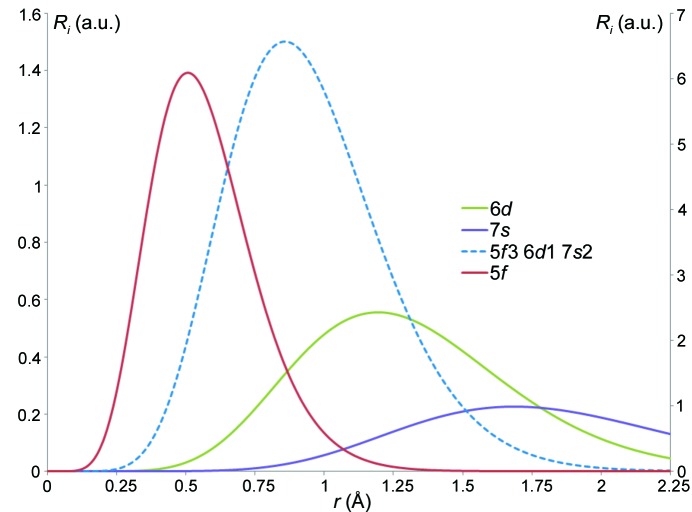
Non-normalized, one-electron single-ζ radial functions for the U atom for the valence levels 7s, 6d and 5f, depicting each separately as well as the weighted average corresponding to the 5f
3 + 6d
1 + 7s
2 configuration. The more contracted 5f radial distribution is plotted according to the right axis, whereas the other more diffuse radial functions are plotted on the left axis.